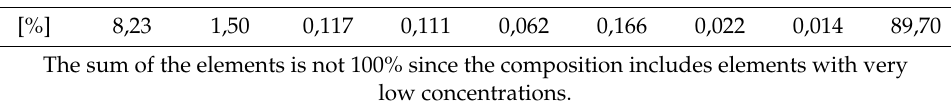
Table 1. Chemical composition of the Al-Si alloy.